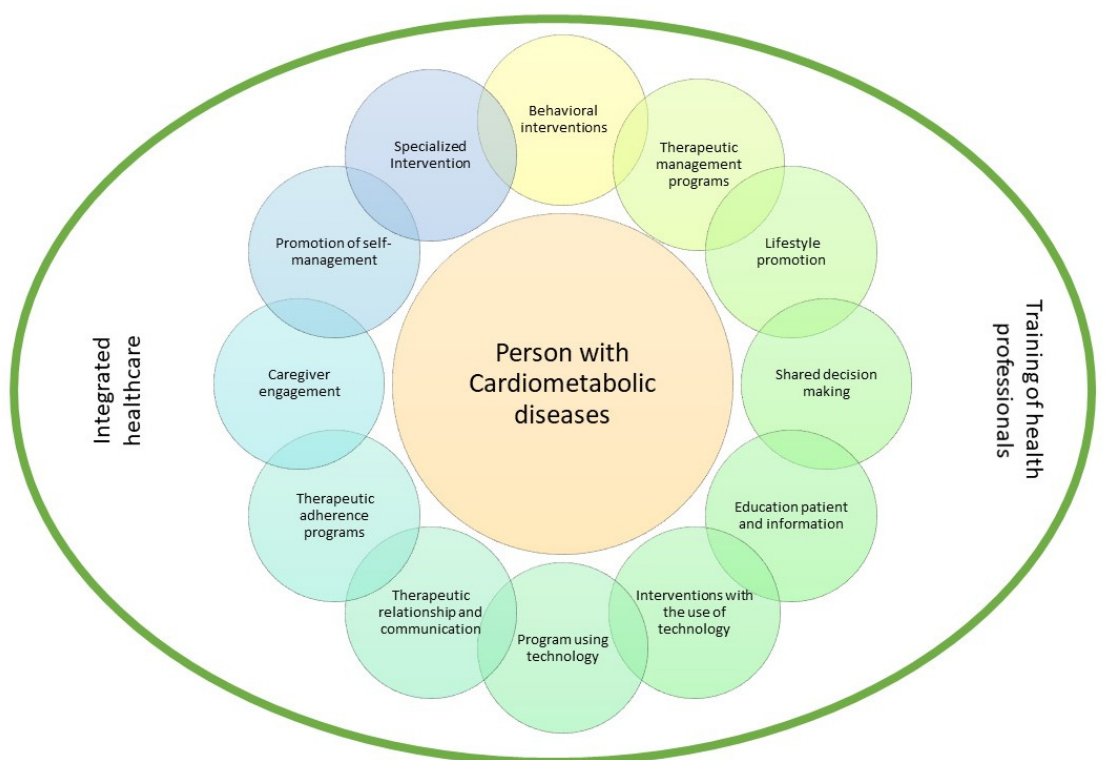
Figure 2. Patient-centered intervention model.